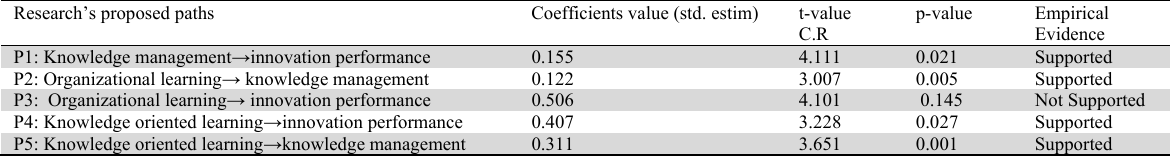
Summary of Proposed Results Research’s proposed paths